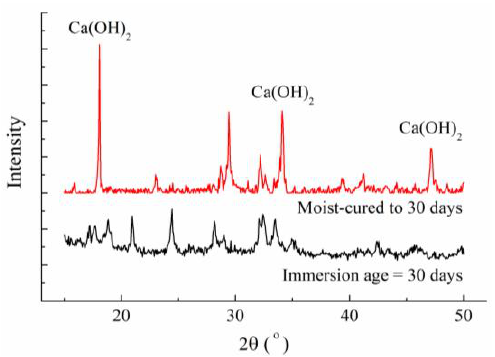
Figure 5. X-ray diffraction (XRD) patterns of concrete specimens at the immersion ages of 0 and 30 days.